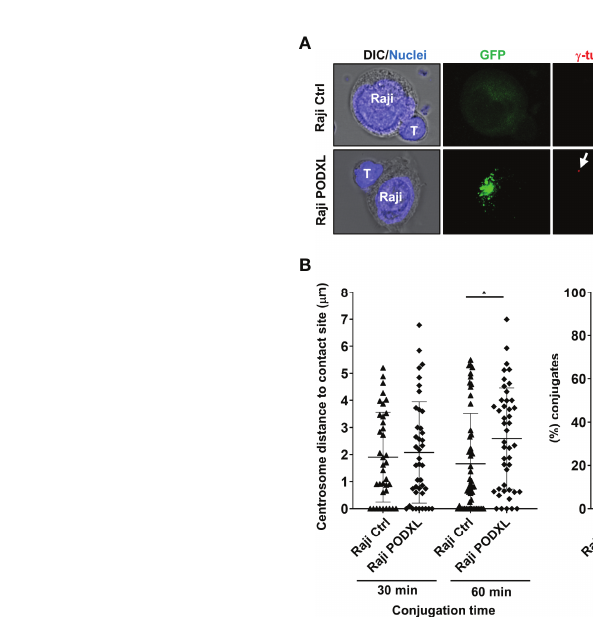
FIGURE 7 | PODXL expressed in APCs perturbs CD4 + T cell-centrosome polarization to the contact site. (A) Raji PODXL or Raji control cells pulsed with SEA were incubated with CD4 + T cells at a ratio of 1:1 for 30 min or 60 min. Then, cells were stained with a monoclonal antibody against g -tubulin to visualize the centrosome (red) and Hoechst 33342 for nuclei staining (blue). Confocal fl uorescence microscopy images show separate and merged channels of maximal intensity z-projections of z-sections from a representative experiment performed at 60 min of incubation. Arrows point to T-cell centrosome in each T-cell. DIC: differential interference contrast. Scale bars correspond to 5 m m. (B) Quanti fi cation of T-cell centrosome polarization in Raji-CD4 + T cells conjugates. Scatter graph depicts the distance of CD4 + T cell centrosome to Raji-cell contact site in each conjugate for a total of 41 (Raji Ctrl, 30 min), 37 (Raji PODXL, 30 min), 51 (Raji Ctrl, 60 min), and 45 (Raji PODXL, 60 min) conjugates from three independent experiments. The results are shown as mean ± SD. *p < 0.05, two-way ANOVA followed by Holm-S ̌ ı ́ da ́ k multiple comparisons test. Bar graph represents the percentage of conjugates in which T-cell centrosome localizes at a distal ( ≥ 3 m m), intermediate (1-3 m m) or proximal ( ≤ 1 m m) distance from Raji-cell contact site for the indicated